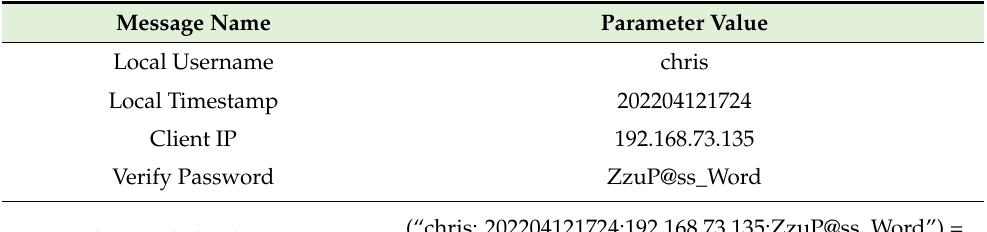
Table 3. SPA information example.